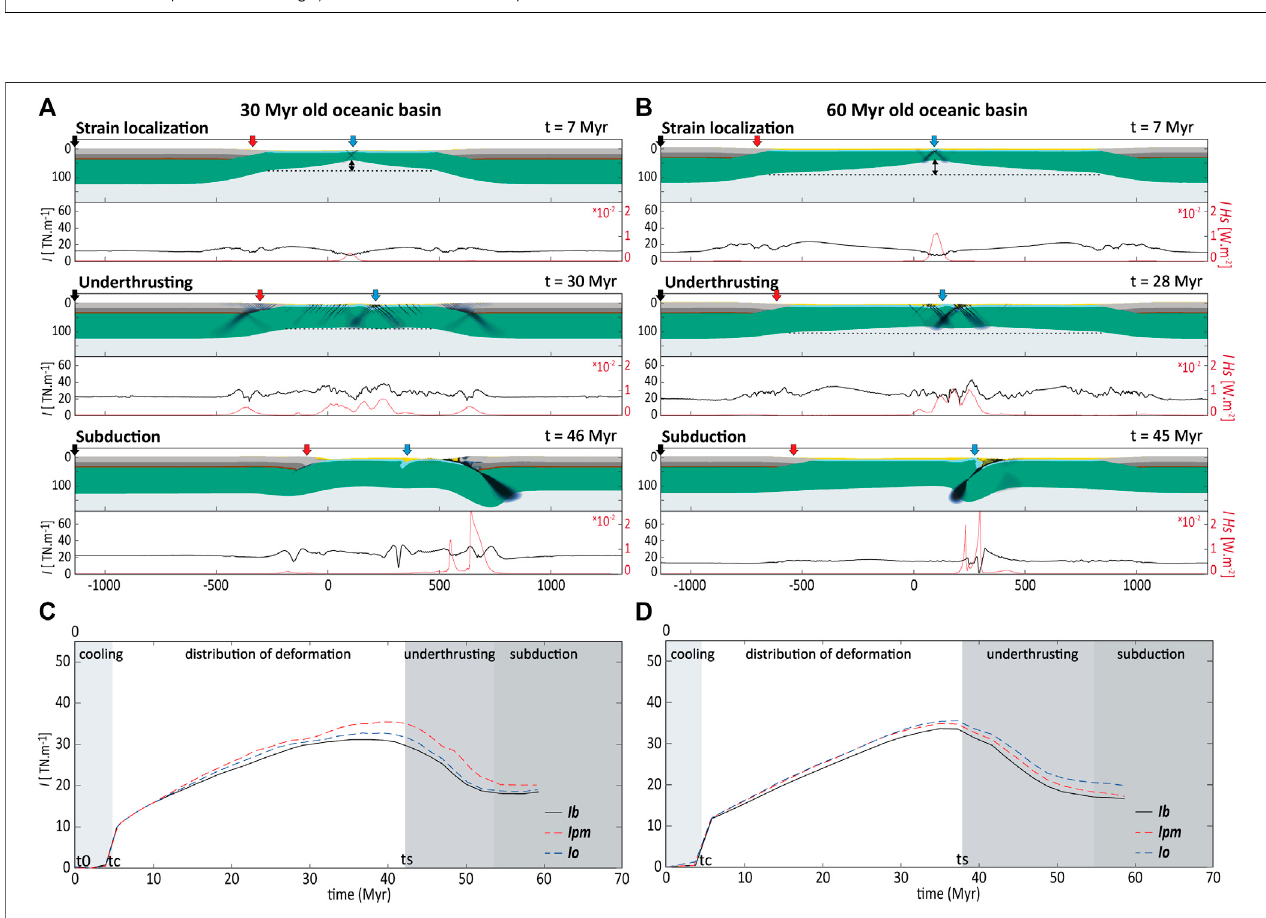
FIGURE 7 | Effect of oceanic basin age on subduction initiation in model series 2. Shortening of a 30 Myr old (left) and a 60 Myr old (right) oceanic basin at convergencerateof0.3 cm yr − 1 (left) afteracoolingperiodof5 Myr. (A – C) Modelevolution,illustratedthroughplotsofmodelcompositionoverlainbyplotsofstrain-rate (top panels) and through plots of integrated stress I (black curve) and integrated heat production by visco-plastic dissipation IHs (red curve) over the thickness of the lithosphere (lower panels) . (C,D) Evolution of integrated stress for three locations: the model boundary, the passive margin, and in the oceanic basin.